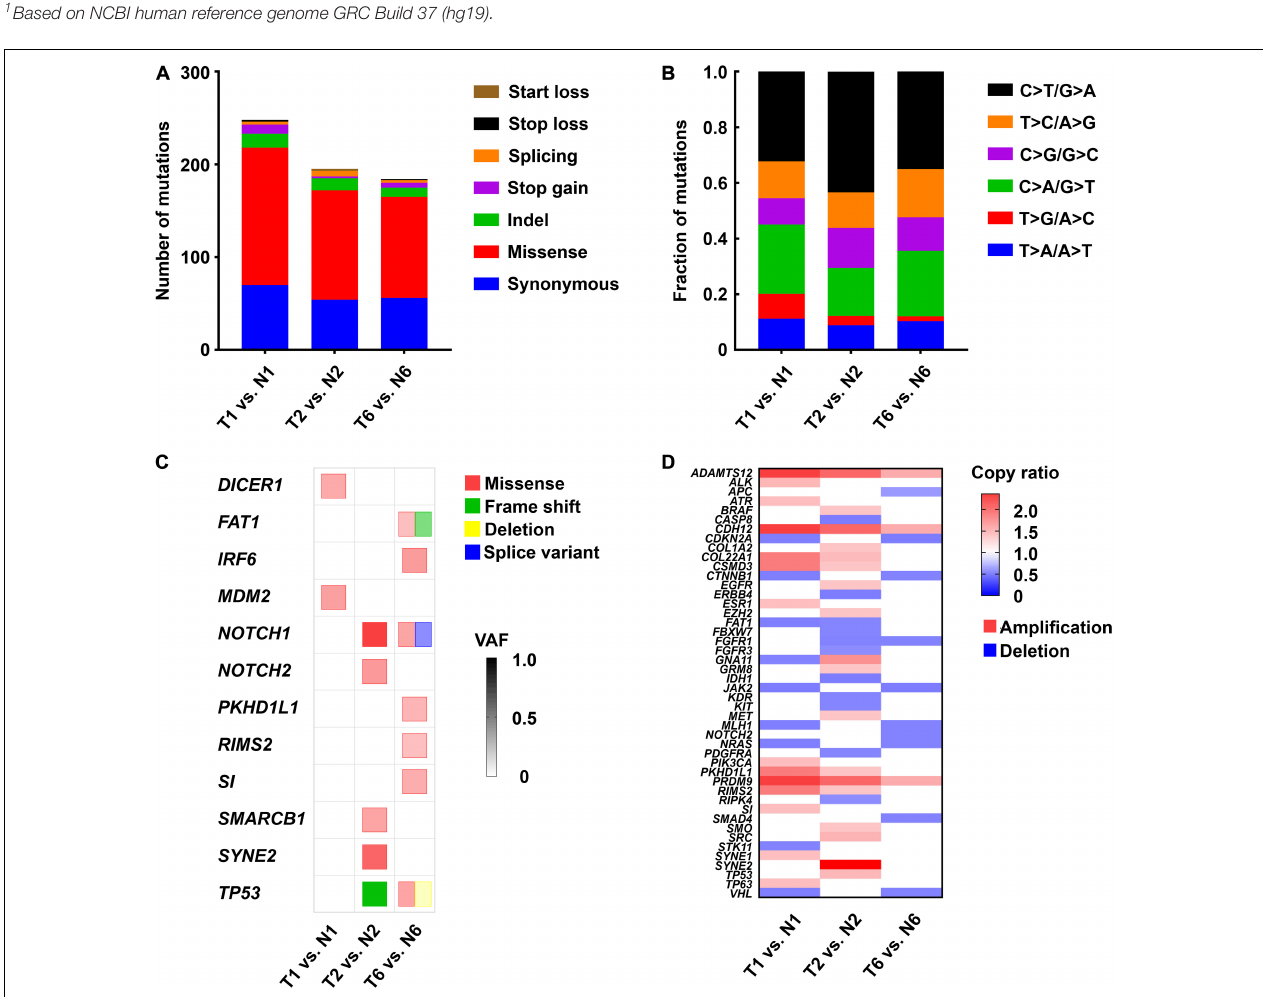
FIGURE 3 | Genetic alterations identified by whole-exome sequencing in 3 paired tumor and normal CRC lines. (A) The number and type of somatic mutations. (B) The spectrum of mutations in LHSCC. (C) Mutations detected in LHSCC-derived CRCs that were sequenced using whole-exome sequencing. The color of the square indicated the type of mutation detected: missense (red), frameshift (green), deletion (yellow), splice variant (blue). Color intensities indicated the variant allele frequency (VAF) of the detected genetic alteration. (D) Heat map of copy number variant (CNV) of tumor-associated genes. Red indicated amplification with copy ratio > 1; blue indicated deletion with copy ratio <